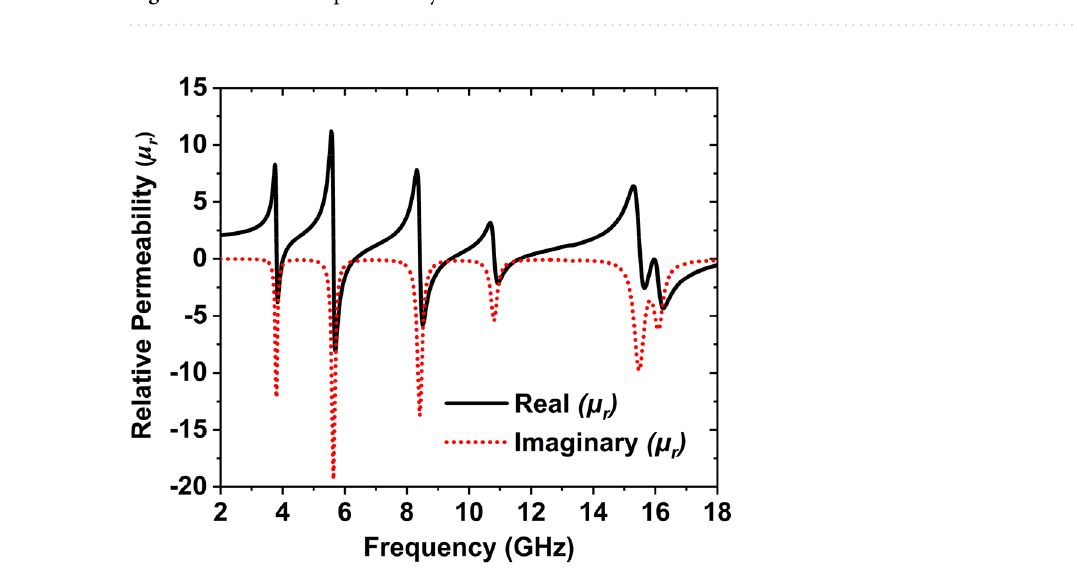
Figure 7. The relative permittivity of the unit cell.